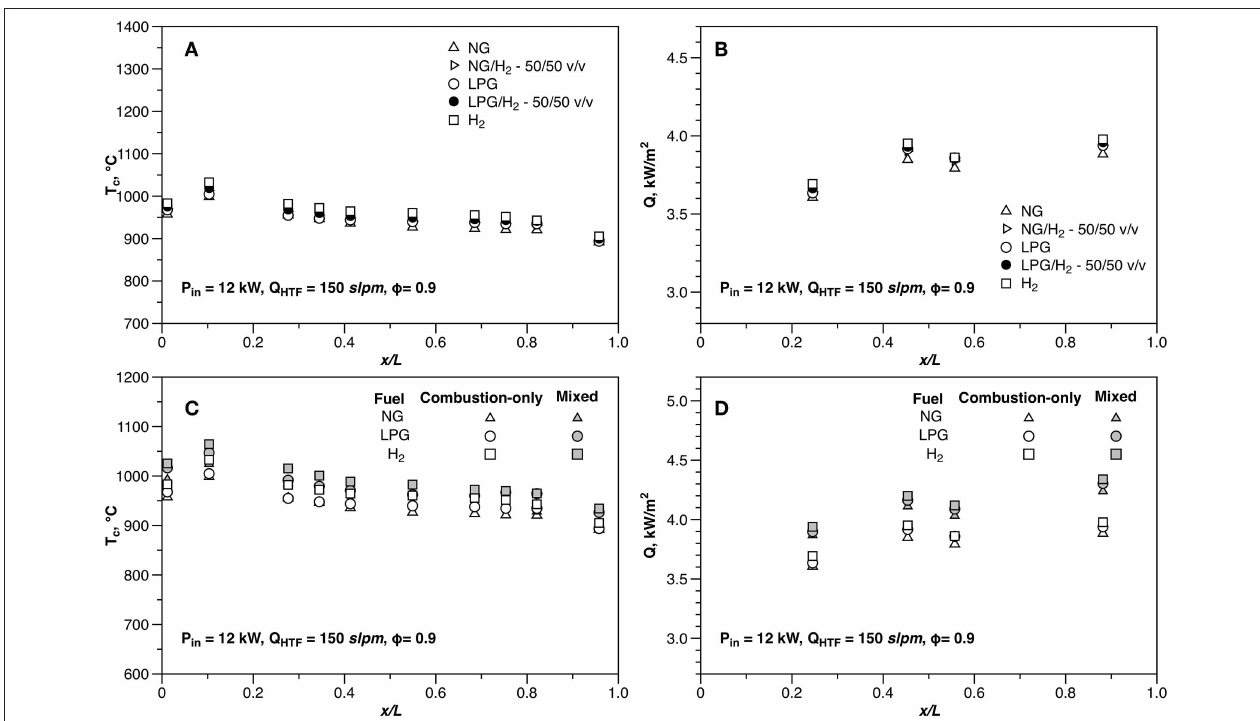
FIGURE 6 | (A,C) Measured axial distribution of the wall cavity temperature, T c , and (B,D) heat flux through the HTF coils, Q , for the MILD (A,B) and mixed (C,D) modes of operation, as a function of the fuel type, and for a fixed HTF flow rate (150 slpm), thermal input ( P in = 12 kW) and equivalence ratio ( φ = 0.9). Data from Chinnici et al. (2018a,b); Chinnici et al.